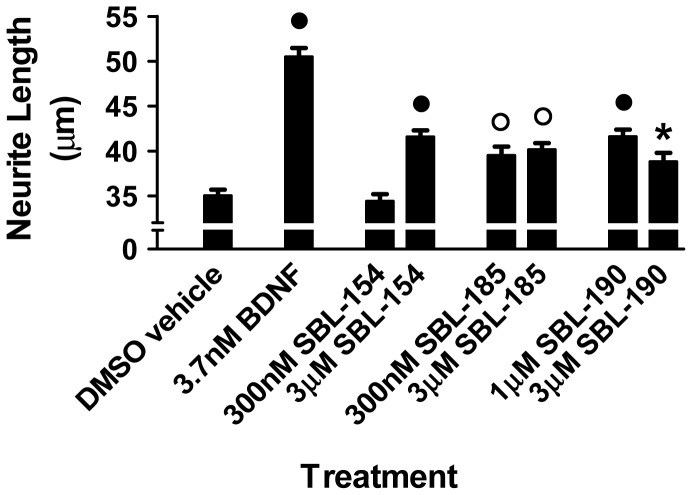
Stimulation of neurite outgrowth in rat spinal motor neurons.Primary cultures of rat embryonic spinal motor neurons were treated with BDNF at 3.7 nM and with SBL-154, SBL-185, and SBL-190 at the two indicated concentrations of each compound. One-way ANOVA with Dunnett’s post test indicates that the positive control BDNF and each compound significantly enhanced neurite outgrowth relative to DMSO vehicle (N = 3 cultures; • p<0.001; ○ p<0.01; * p<0.05).